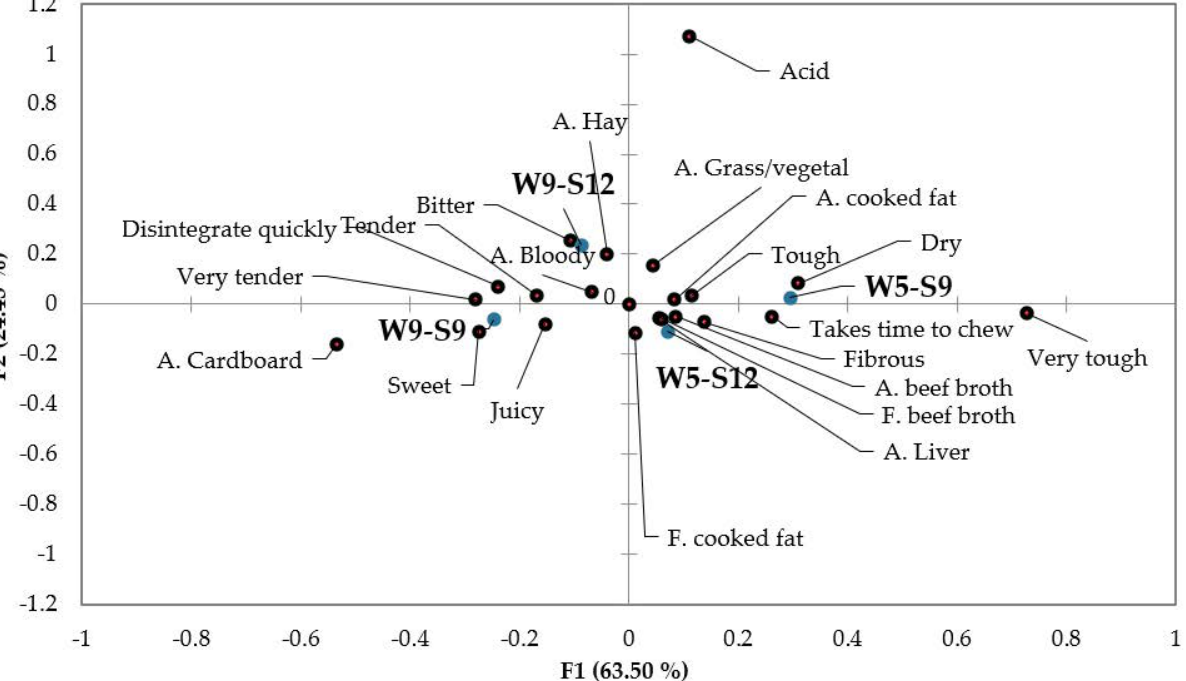
Figure 1. Attributes of Arouquesa meat tested (in blue) in the space defined by the first two factors (A.—Aroma;